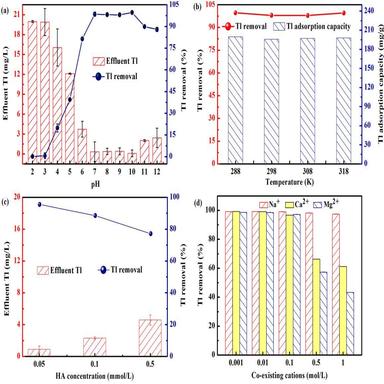
The influencing factors on Tl(I) removal: (a) solution pH, (b) reaction temperature, (c) humate concentration and (d) co-existing cations (Tl(I)0 = 20 mg/L, NaClO dosage = 10 mM, nZVIM dosage = 0.10 g/L, solution pH = 10, reaction temperature = 298 K, reaction time = 30 min).